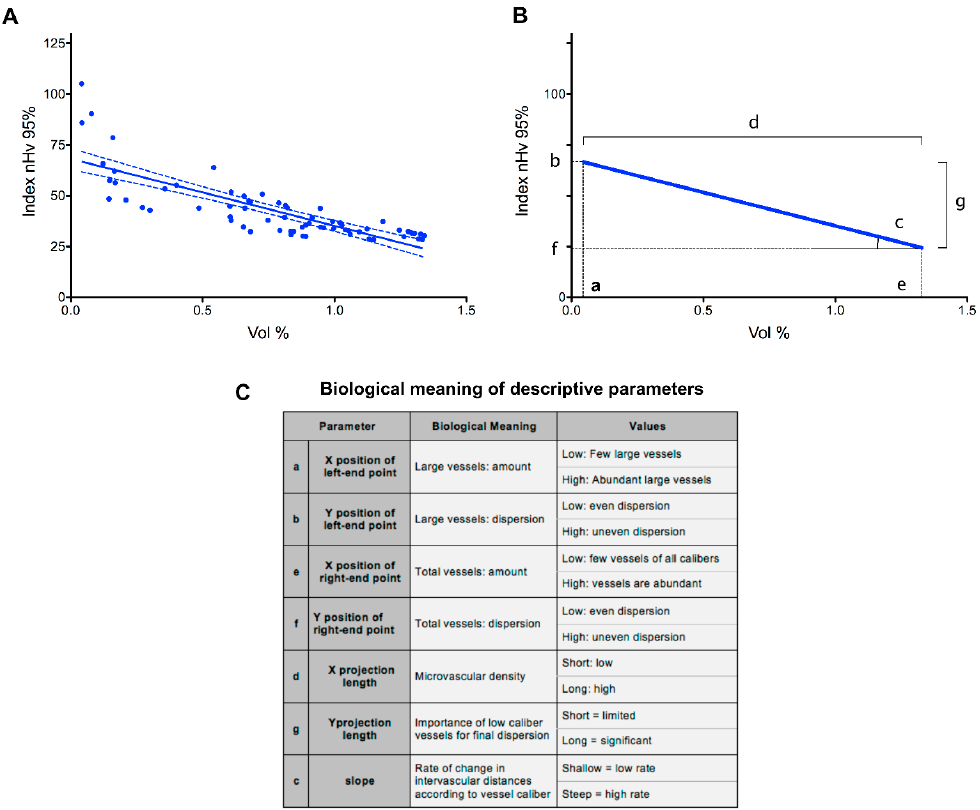
Figure 3. Graphical representation and biological meaning of parameters from the analysis of the microvascular angioarchitecture of the murine brain cortex. ( A ) Regression line obtained from partially reconstituted microvascular angioarchitectures of 11 z-stacks acquired from prefrontal cortex samples of four wt animals. Data are shown as signal amount (Vol %) versus signal dispersion (nHv 95%) plot with points reporting the analytical values obtained (6 points × 11 stacks); dotted lines indicate 95% confidence intervals. ( B ) Schematic representation of the experimental results shown in panel A. The parameters obtained from the regression line are indicated by letters a to g, and their biological significance is summarized in panel C . The table also reports the meaning for the low or high values for each parameter. See text for further details.